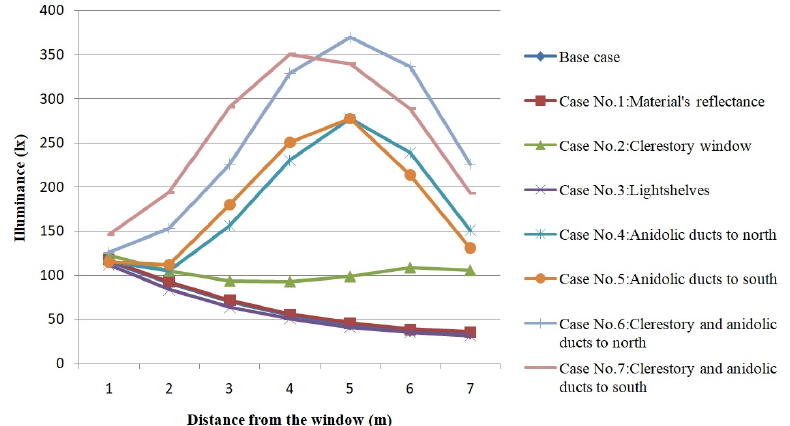
Figure 17. Comparison of average illuminance levels on the desks plane on 21 st of March at 3:00 pm.